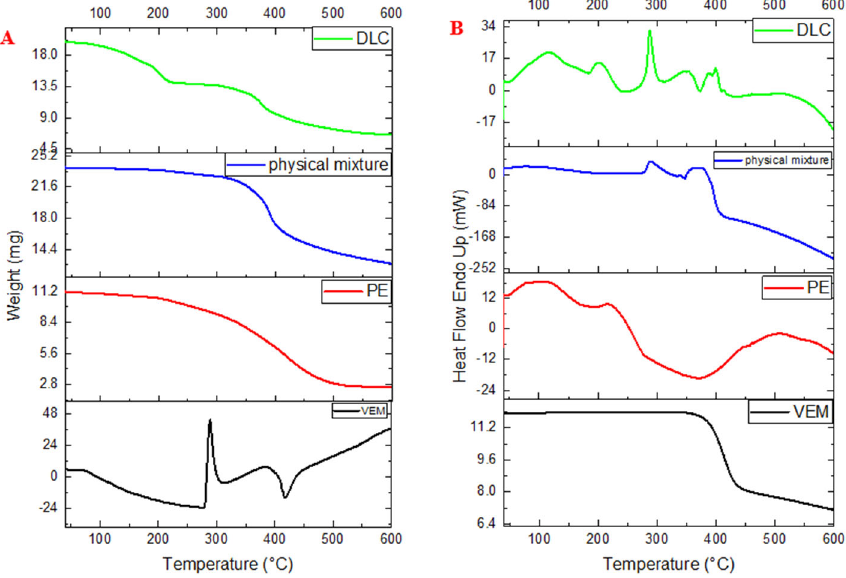
Figure 6. (A) DSC and (B) TGA of Pure VEM, Pure lipid (PE), physical mixture of VEM and PE, and DLC (drug-lipid